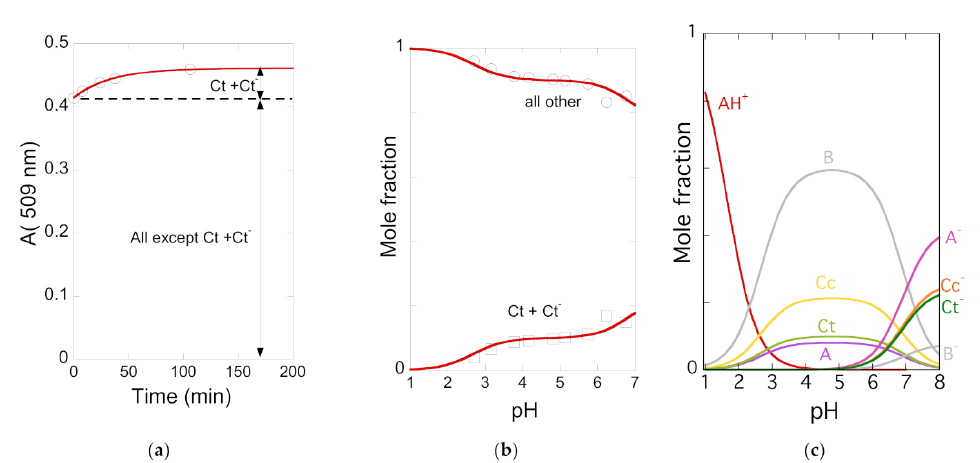
Figure 3. ( a ) Trace of a reverse pH jump of an equilibrated solution of kuromanin at pH = 5.1 followed at 509 nm by standard spectrophotometer; ( b ) mole fraction distribution of trans -chalcone at the equilibrium; and ( c ) mole fraction distribution of all AH + , CB, and CB − species at the